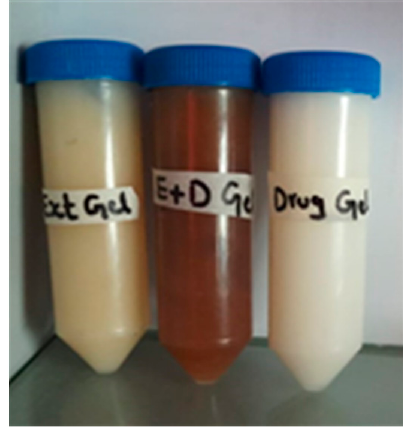
Figure 1. Topical Nanogels.